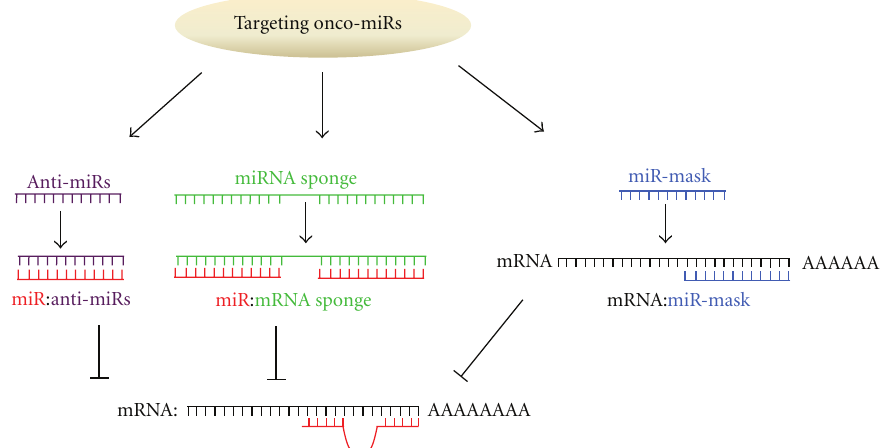
Figure 3: miRNA-based molecular cancer therapy for oncogenic miRNAs. The cancer therapies include anti-miRNA oligonucleotides (anti- miRs), miRNA sponges, and miRNA